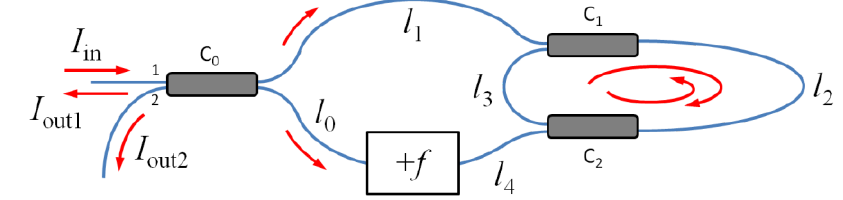
Figure 7. An FSI-CRD system with a fiber loop cavity. C C and C : highly unbalanced fiber directional 1 2